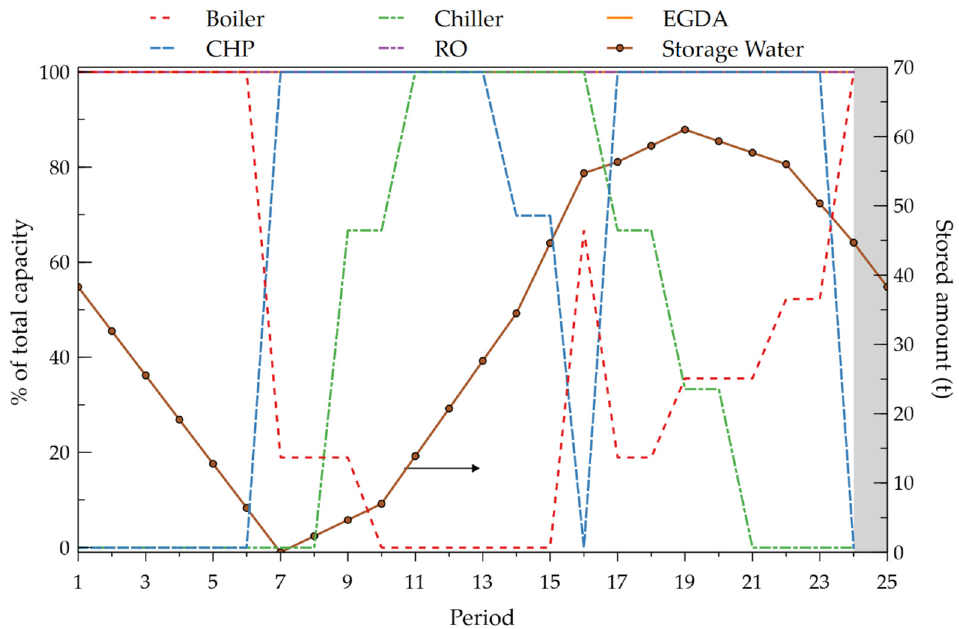
Figure 11. Operating state of the units for best solution in case 3 with limit of 30,000 kg CO 2 eq./day.